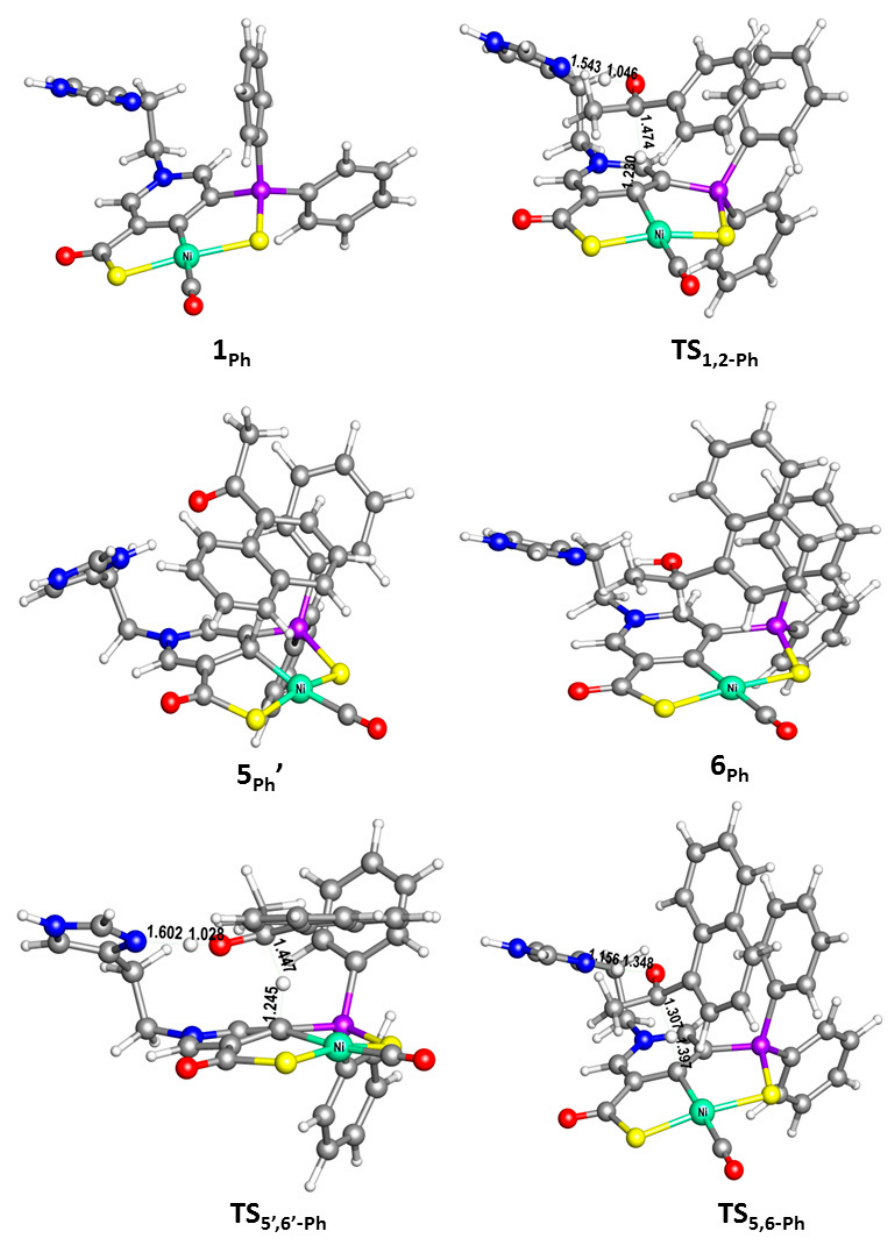
Figure 3. Optimized structure of 1 Ph , TS 1,2-Ph (687 i cm -1 ), 5 Ph ’, 6 Ph, TS 5’,6’-Ph (746 i cm -1 ), and TS 5,6-Ph (1099 i cm -1 ). Bond lengths are in angstrom. (cyan: Ni, yellow: S, blue: N, red: O, grey: C, white: H)